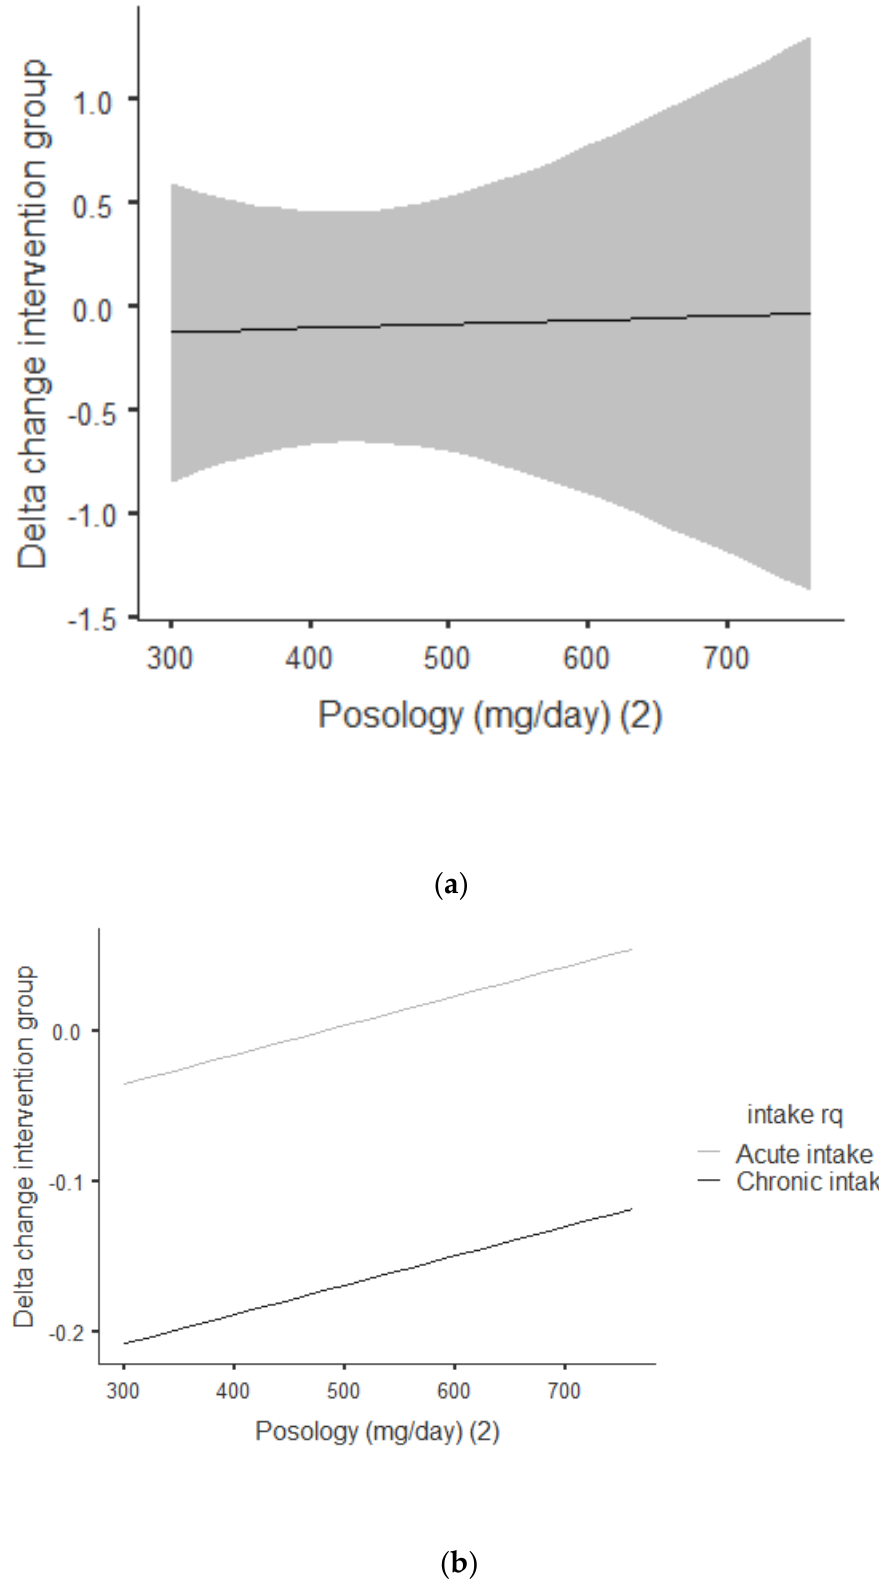
Figure 3. ( a ) Dose – response of green tea catechin intake on RQ. ( b ) Dose – response of green tea catechin intake on RQ.